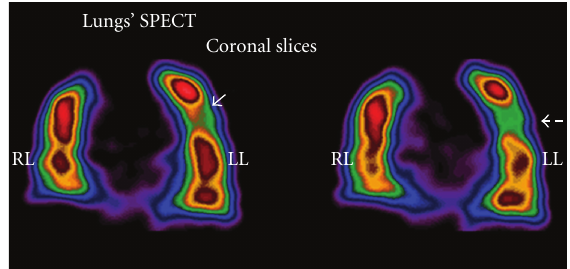
Figure 11: Two sequential coronal slices indicating mild pulmonary embolism in left lung lobe (LL) not indicating in planar images. Image reconstruction has been completed by FBP and Butterworth filter (critical frequency 0.5, order 10). Courtesy of M. Gavrilelli (MSc, “Medical Imaging Center” Athens,